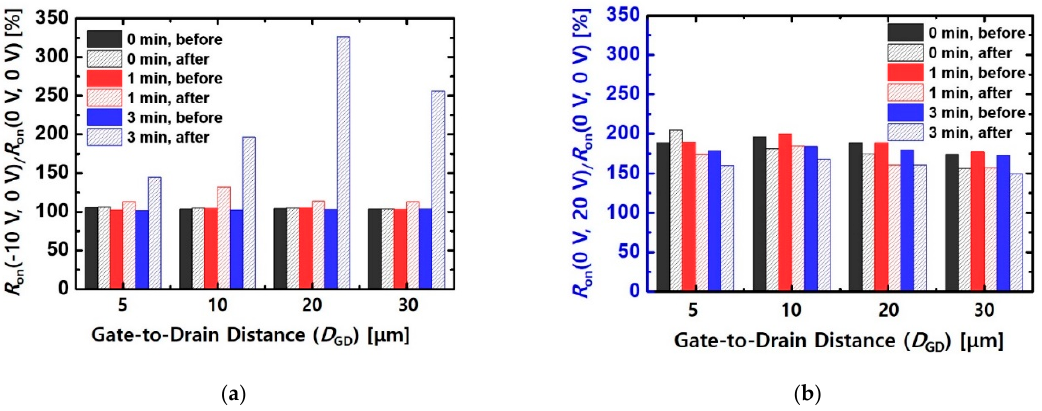
Figure 8. Variation in rates of R on depending on ( a ) gate and ( b ) drain stress bias conditions of the MIS ‐ HEMTs with different values of D GD . The P period and P width were 5 ms and 100 μ s, respectively.